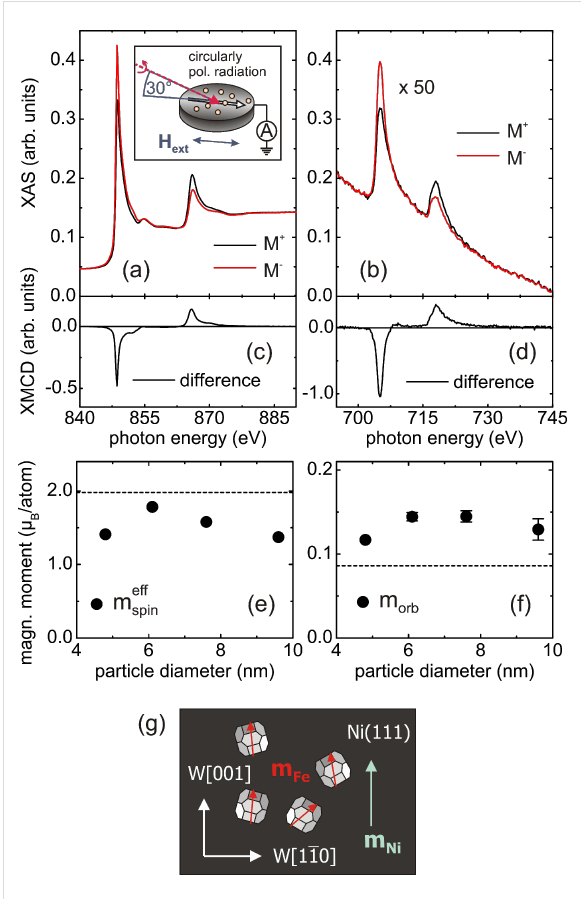
Figure 2: (a) X-ray absorption spectra of the Ni(111) substrate. Inset: Schematics of the experiment. (b) XAS spectra of the Fe NPs with a diameter of (7.6 ± 1.5) nm. (c),(d): Ni- and Fe-related XMCD spectra. Lower part: Size-dependent magnetic spin moments (e) and magnetic